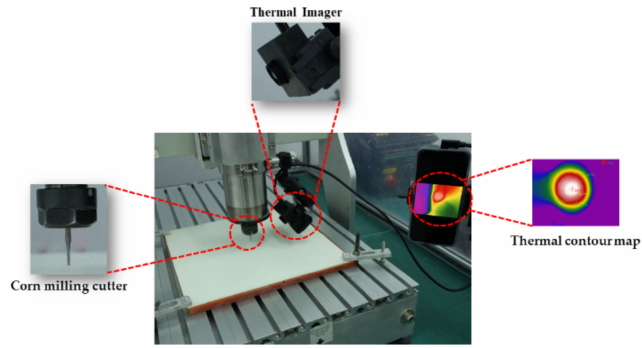
Figure 2. Thermal-imaging setup.